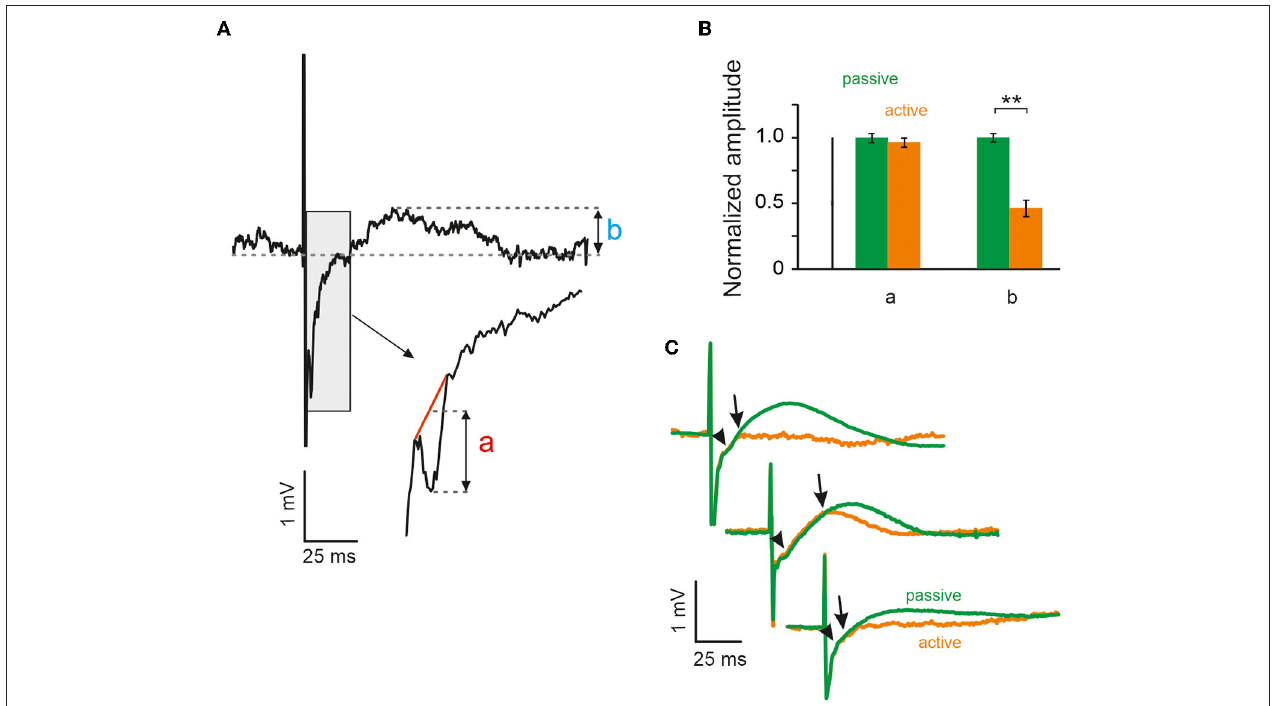
FIGURE 2 | Whisking reduces evoked local field potential (LFP) activity during the inhibitory period but not during the excitatory period. (A) Example of LFP response, which demonstrates sharp negative deflection (a) followed by long positive wave (b), presumably corresponding to electrically evoked excitation and inhibition respectively (cf. Figure 1D ). (B) Peak amplitudes of excitatory LFP response (a) to both active and passive contacts yielded no difference, unlike amplitude of the inhibitory period (b), which had higher maximum amplitude during passive contacts in all three animals (**significant using Mann-Whitney U -test, error bars CI95, see text). (C) Mean LFP responses to both passive (green) and active (orange) contacts in all three animals (the infraorbital nerve was cut in the animal shown on